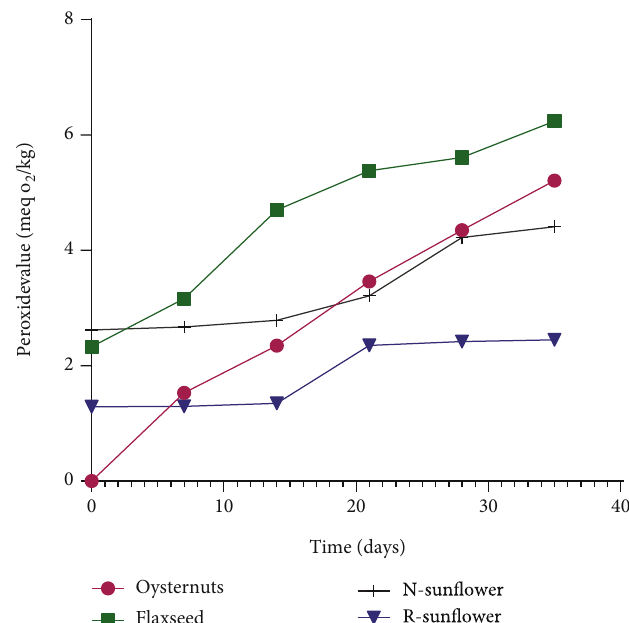
Figure 3: Line graphs showing variations in peroxide values (PV) of oyster nut oil, fl axseed oil, nonre fi ned sun fl ower oil, and re fi ned sun fl ower oil samples stored at 25 ° C for a 40-day period.